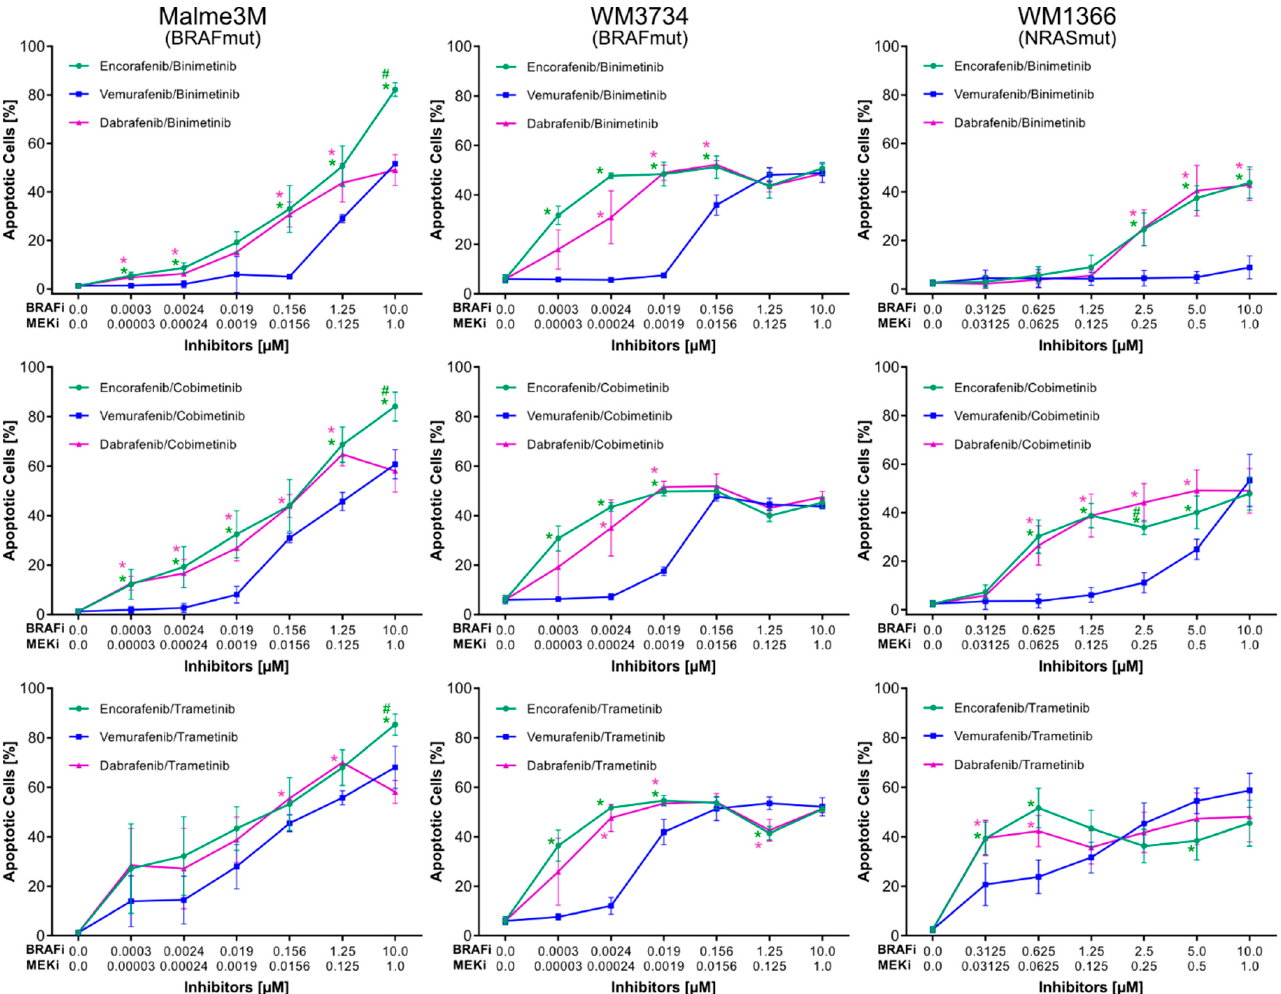
Figure 1. Sub-G1 analysis (apoptosis) of two BRAF mut cell lines (Malme3M and WM3734) and one NRAS mut cell line (WM1366) after treatment for 72 h using different BRAFi/MEKi combinations with increasing concentrations of inhibitors (BRAF mut 1:8 serial dilutions, NRAS mut 1:2 serial dilutions). n ≥ 3, error bars indicate standard deviation, * indicates significantly different values relative to vermurafenib, # labels data points significantly different relative to dabrafenib. Significance defined as p < 0.05 based on a two-tailed non-paired t -test. Table S1 shows a complete list of p -values for all data points.